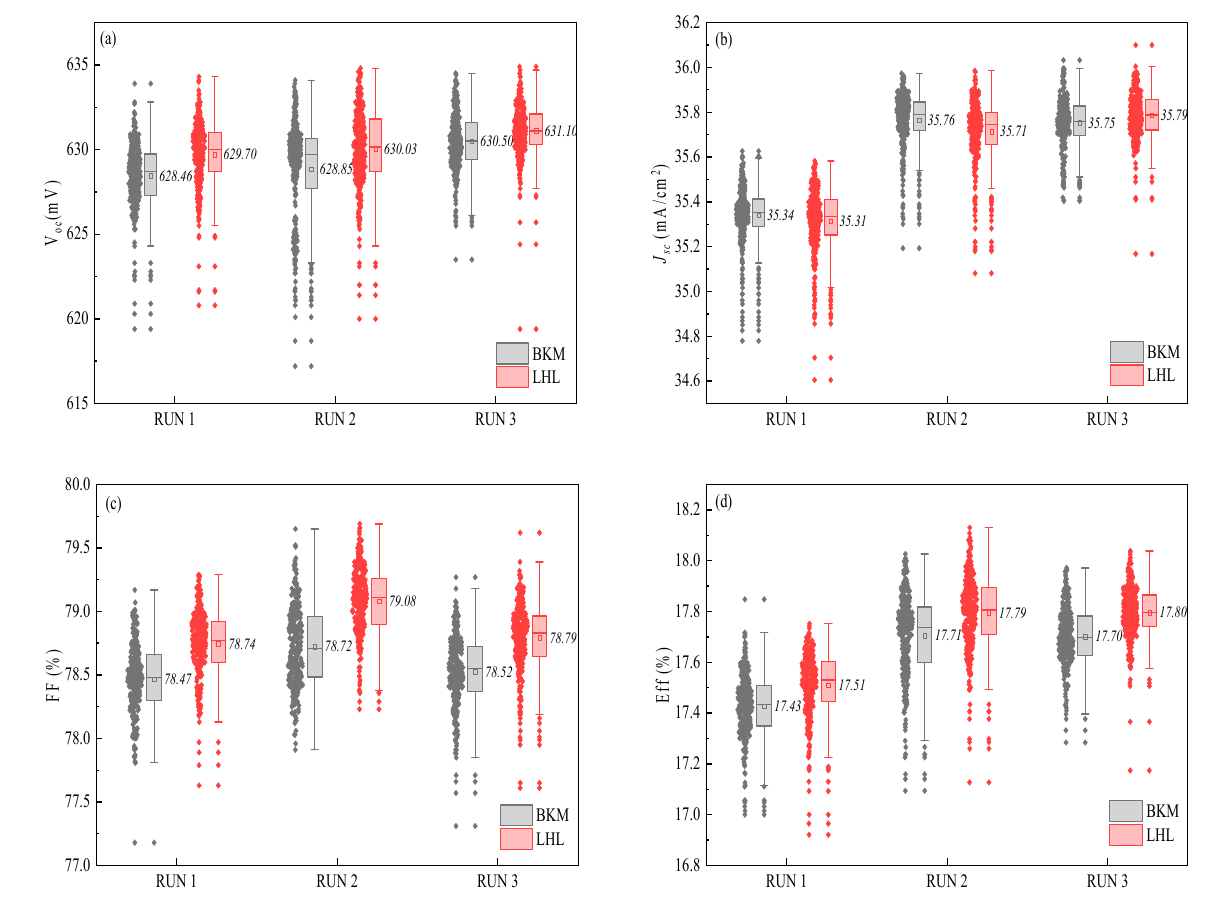
Figure 4. Box plots of the electrical characteristics of solar cells obtained from BKM and LHL diffusion processes ( a ) V oc , ( b ) J sc , ( c ) FF, and ( d ) E ff .